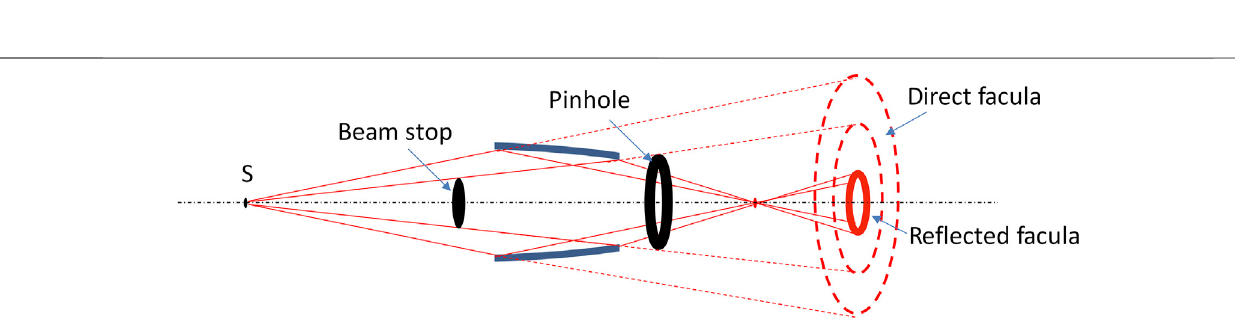
FIGURE 8 | (A) Intensity distribution with angle (red line) and proportion of the output x-ray beam irradiating on the theoretical region. (B) Annulus width of the ring shape facula from the condenser at different angles.